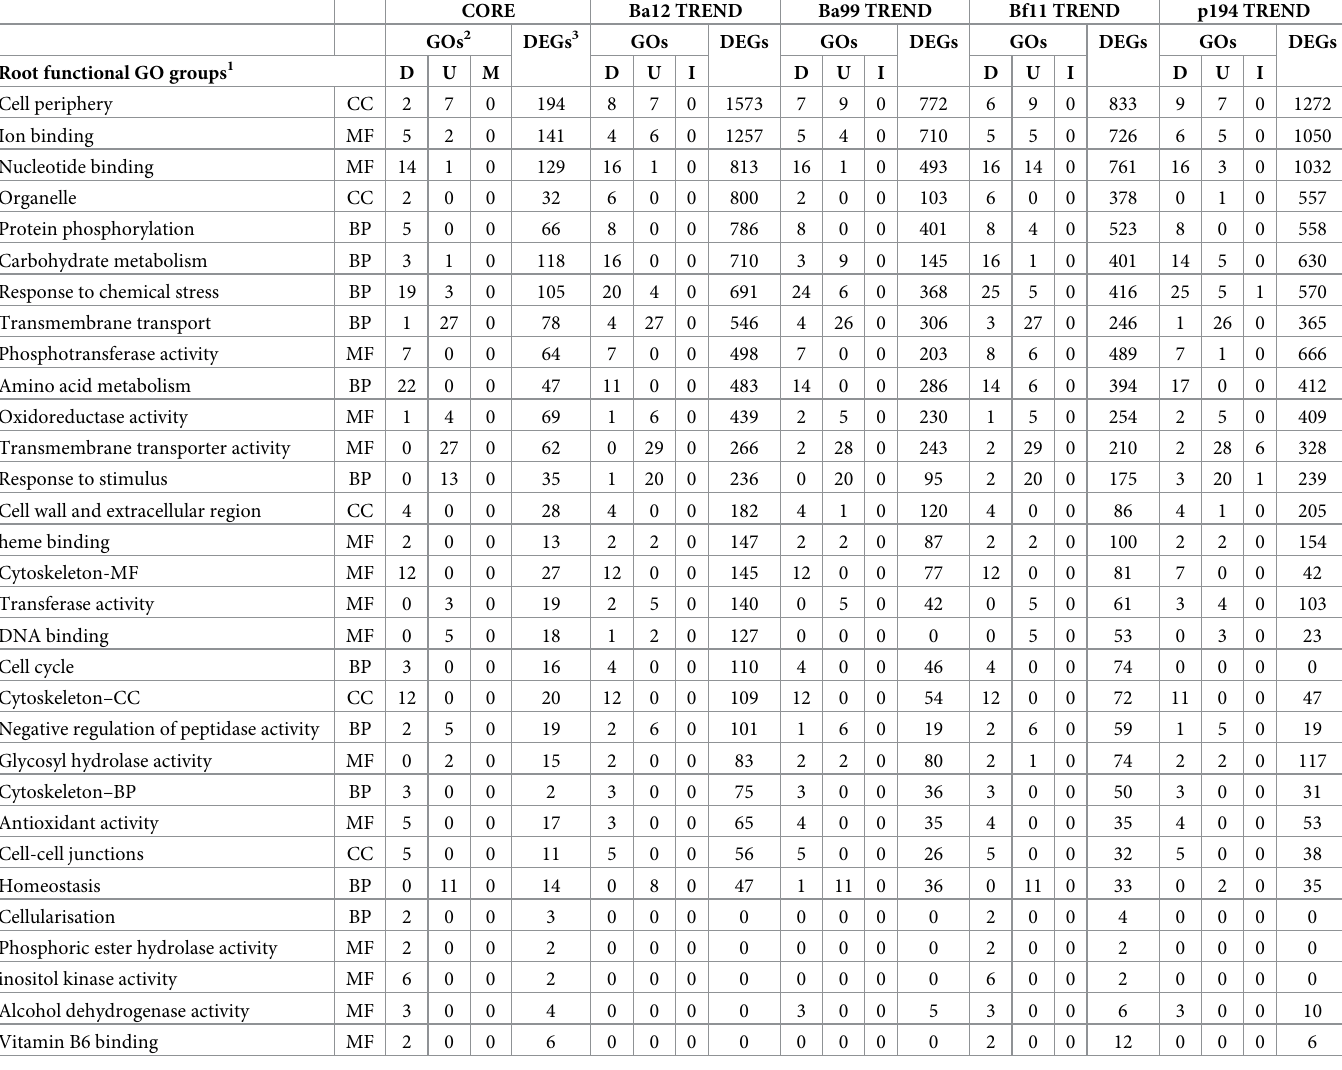
Table 3. The number of significantly enriched GO terms and total numbers of associated DEGs assigned to putative functional areas in the root for the core and trend